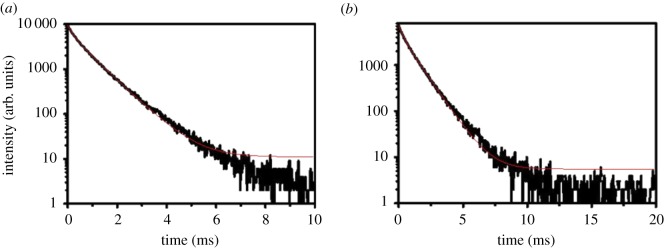
Lifetime curve of SiO2@ANA-Si-Tb-phen (a) and SiO2@ANA-Si-Tb-phen@SiO2 (b).